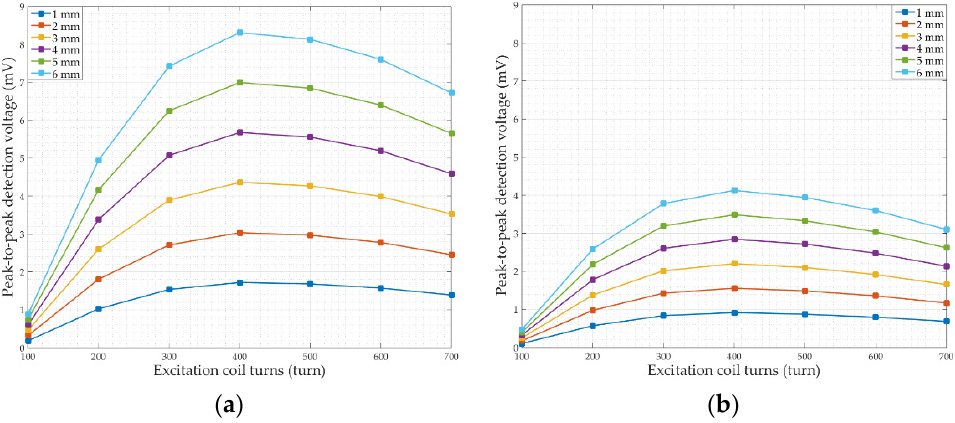
Figure 6. ( a ) Detection voltage amplitude of circumferential cracks with different turns of excitation coil; ( b ) detection voltage amplitude of axial cracks with different turns of excitation coil.